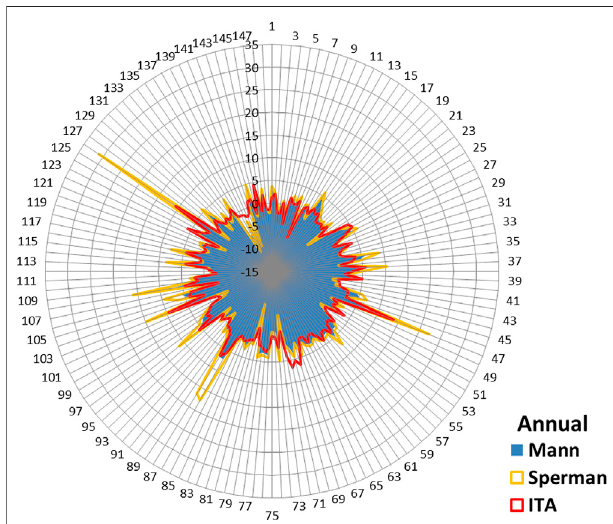
FIGURE9| Comparison betweenannualtrendsvaluesobtainedbyMK, SR and ITA method.